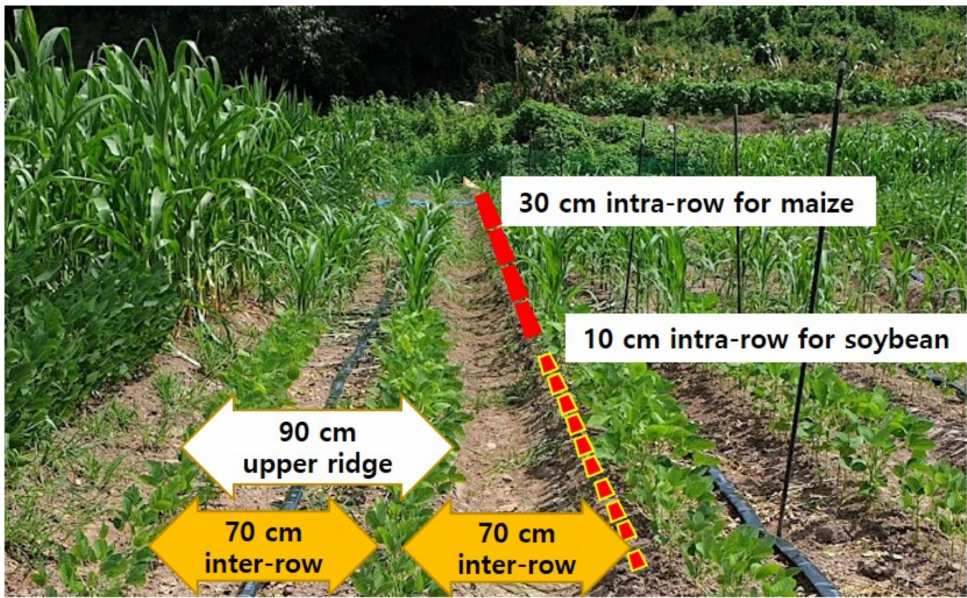
Figure 1. Intra-row and inter-row spacing of maize and soybean on the